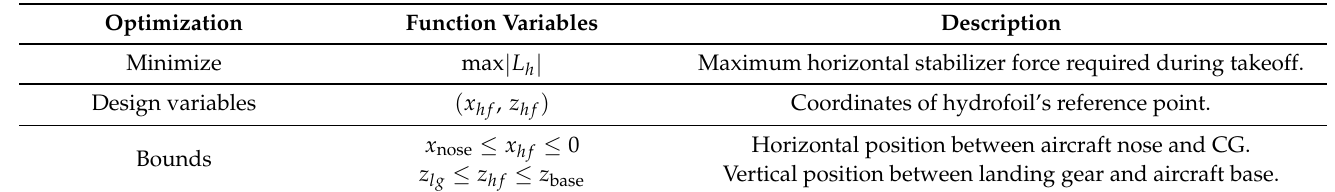
Table 2. Optimization problem formulation to determine the hydrofoil’s location.